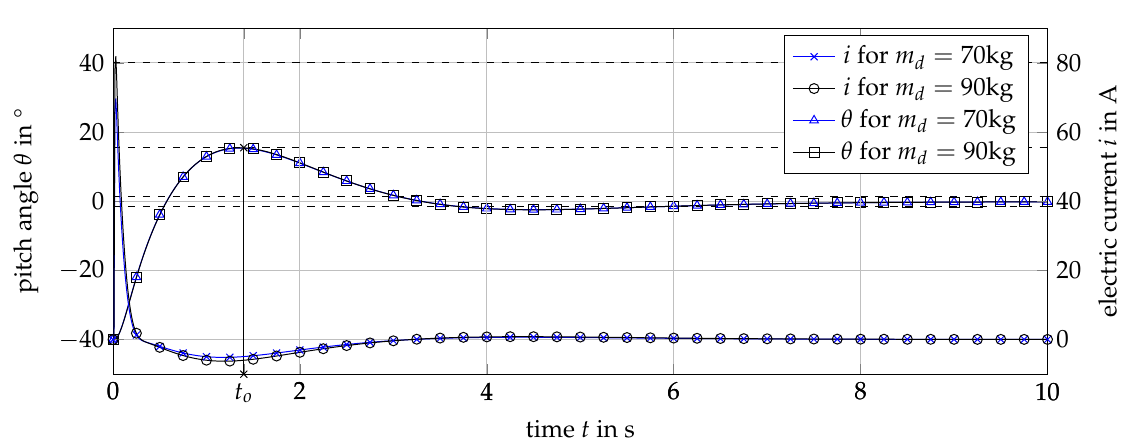
Figure 25. Simulation data of the stability